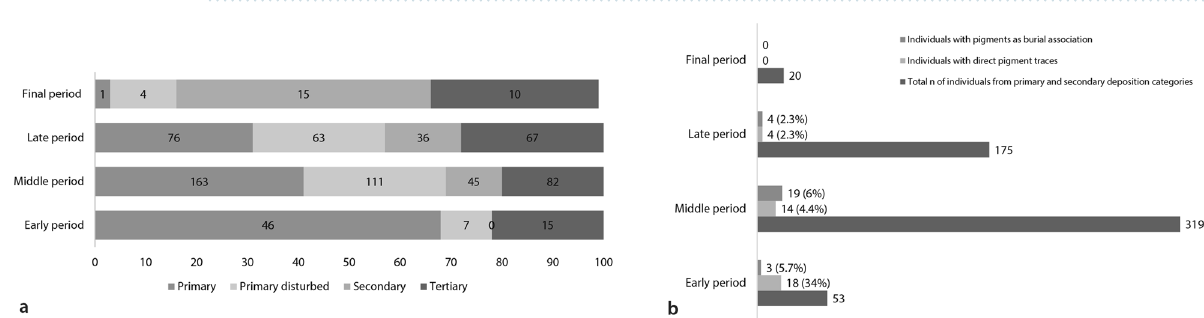
Figure 4. ( a ) Diachronic distribution of the different depositional categories; ( b ) Number of individuals and relative percentages of individuals with direct pigment traces and with pigments as associated items by occupation period (n = number). Charts generated with Microsoft Office Excel 2016 (https:// www. micro soft. com/ en- us/ micro soft- 365/